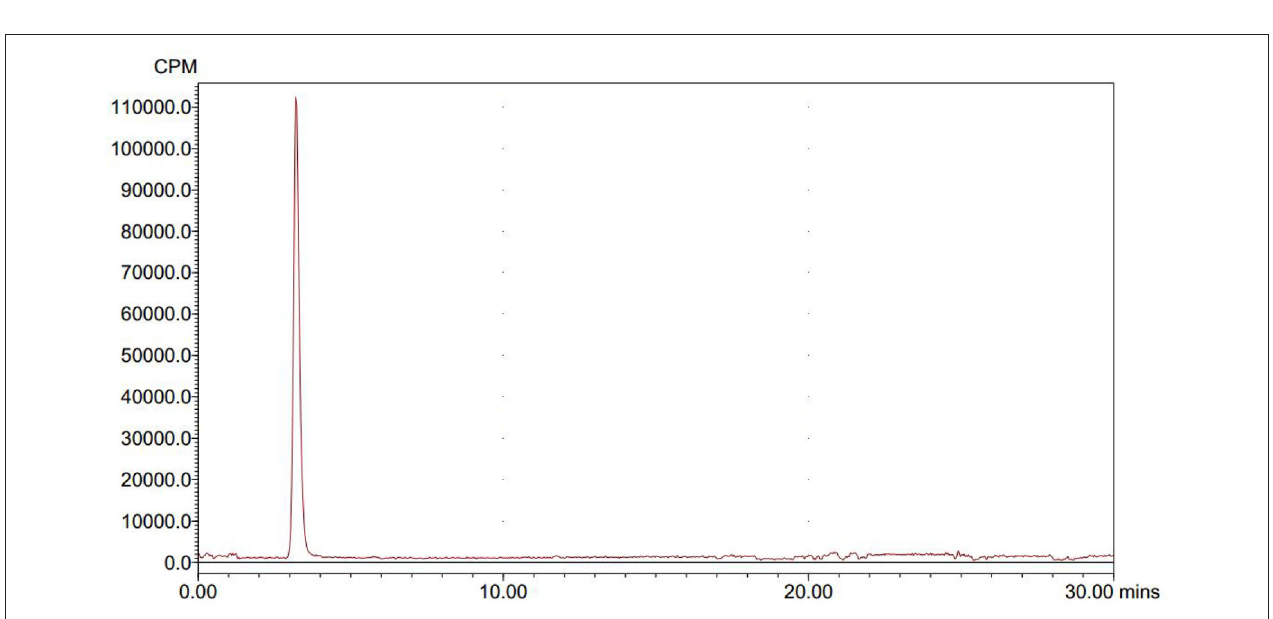
FIGURE 2 | The final solution of [ 18 F]DPA714 was injected into a analytic reversed-phase HPLC to determine its radio-chemical purity, the retention time (tR) of [ 18 F]DPA714 was 3.5 min with a mobile phase of CH 3 CN, deionized water and triethylamine (40:60:0.1, v/v/v) setting the flow rate at 1.0